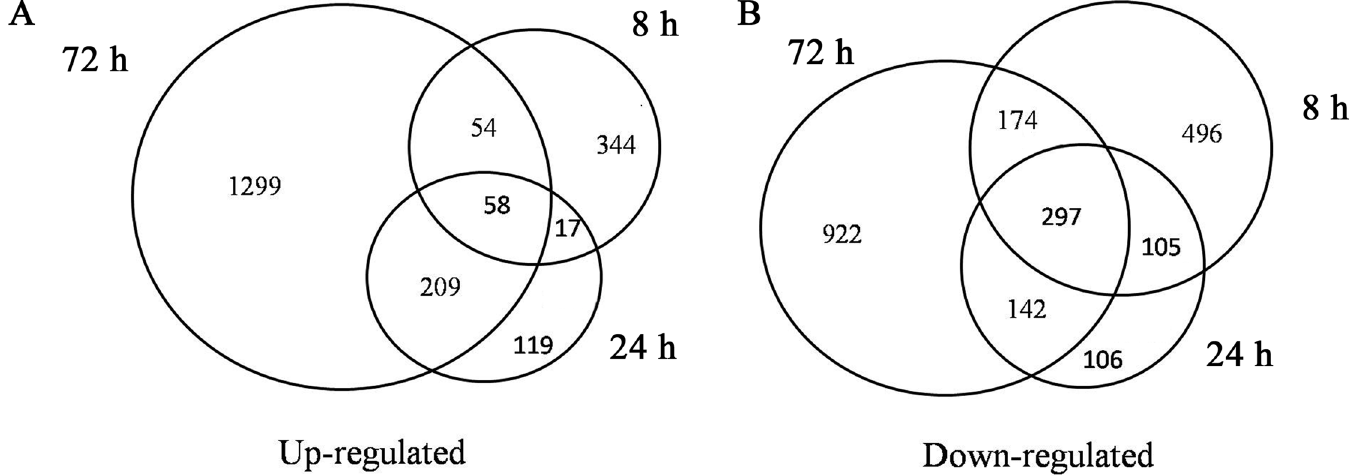
Fig 3. Venn diagrams of sugarcane genes showing changes in the level of transcripts in response to low-K stress. Venn diagrams of up-regulated ( A ) and down-regulated ( B ) genes at different times points after the initiation of low-K treatment. Genes that were up-regulated at at least at one time point (8 h, 24 h and 72 h) were selected for the analysis in ( A ). Genes that were down-regulated at at least one time point (8 h, 24 h and 72 h) were selected for the analysis in ( B